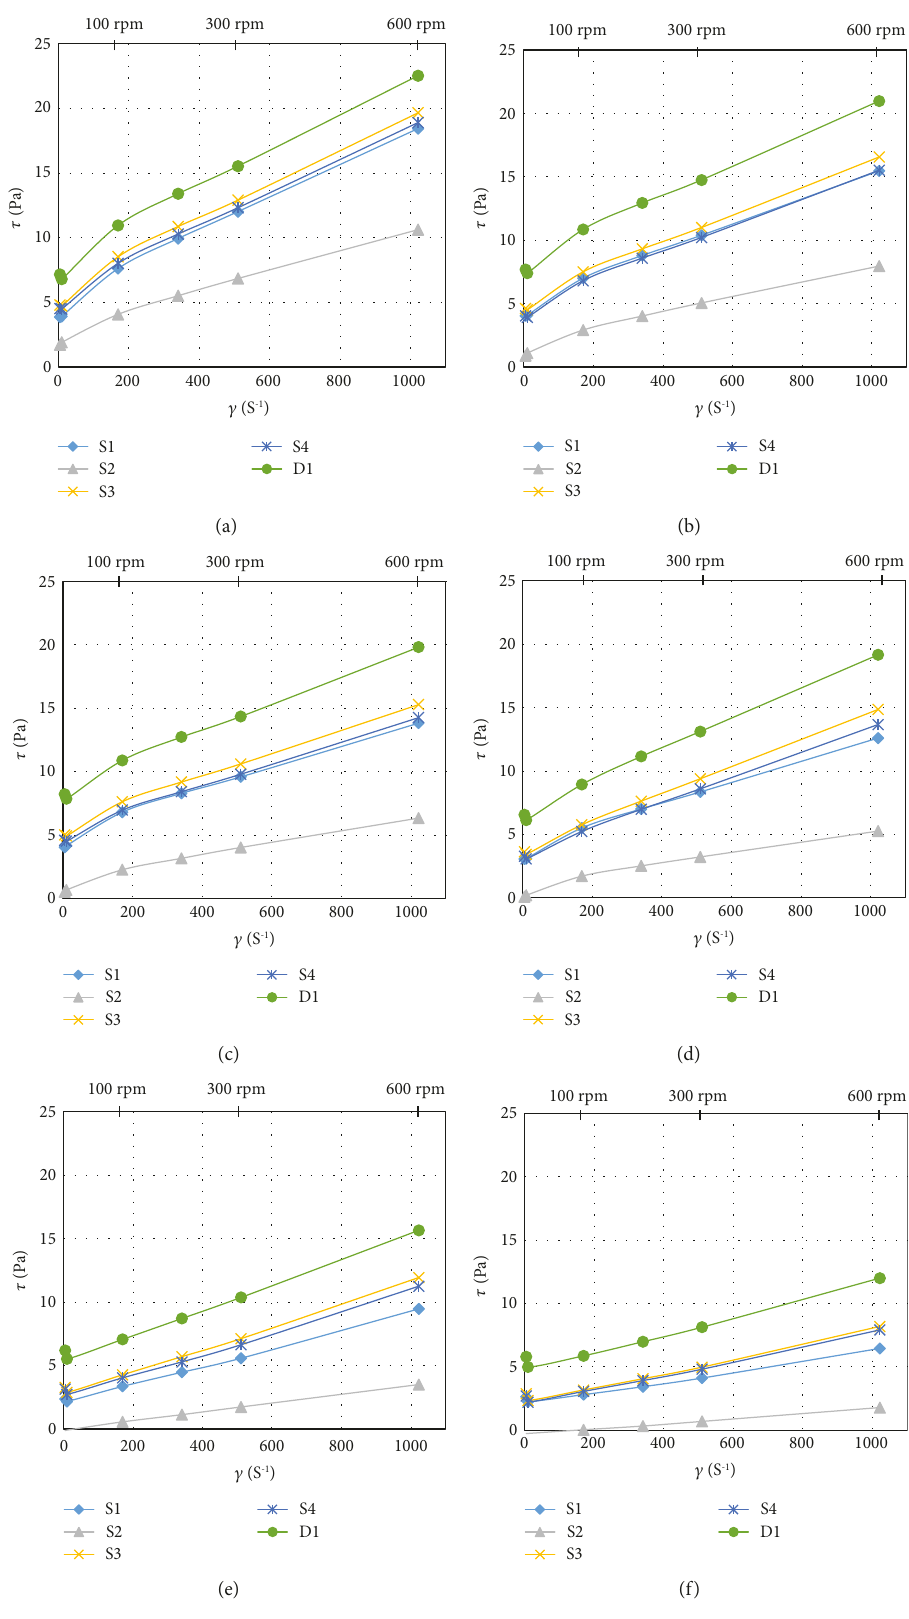
Figure 3: The rheograms of the S 1, S 2, S 3, S 4, and D 1 samples at constant temperatures (a) 77 ° F, (b) 122 ° F, (c) 167 ° F, (d) 212 ° F, (e) 257 ° F, and (f) 302 °